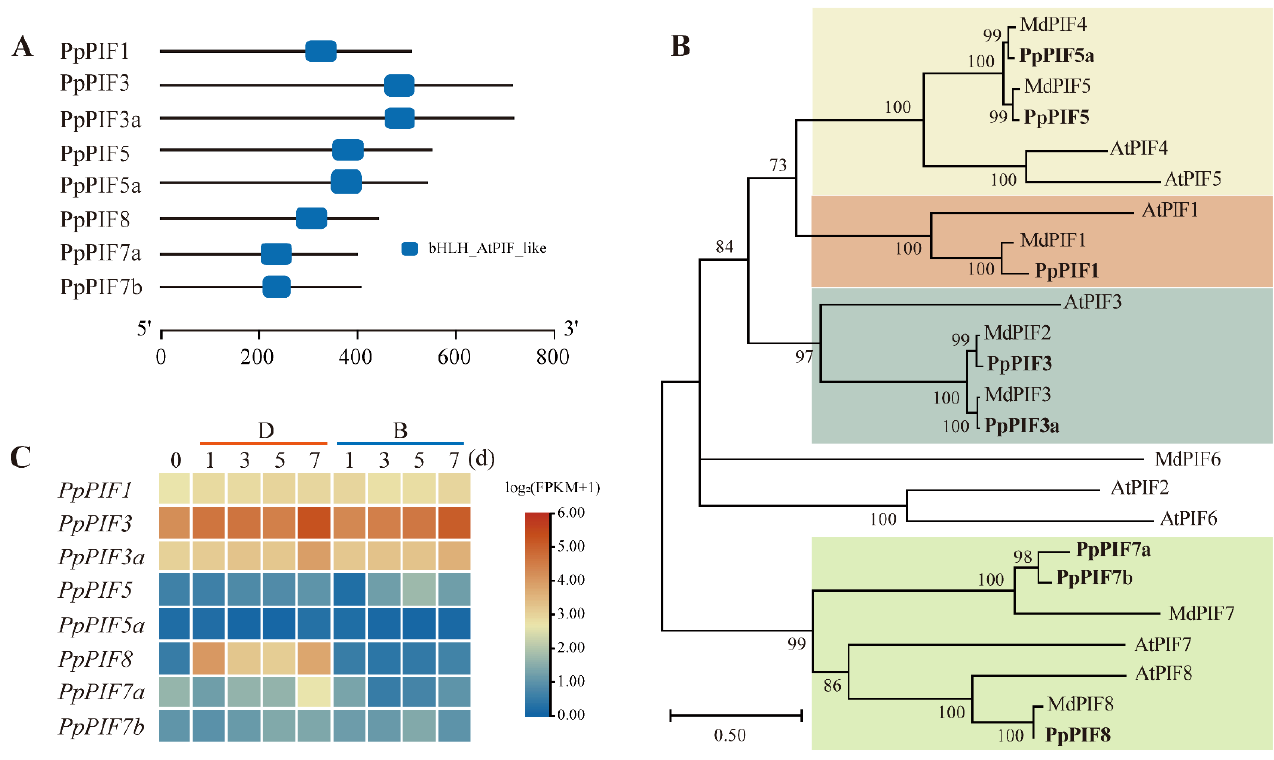
Figure 8. Genome-wide identification of PpPIFs. ( A ) PpPIFs contains a conserved bHLH_AtPIF_like domain. ( B ) Phylogenetic tree analysis of PIFs from pear, apple, and Arabidopsis thaliana . ( C ) The expression pattern of PpPIF1 , PpPIF3 , PpPIF5 , and PpPIF8 . ‘B’ represents bagged samples, while ‘D’ indicates debagged samples. Table 2. Characteristics of phytochrome-interacting factors (PIFs) genes in pear.